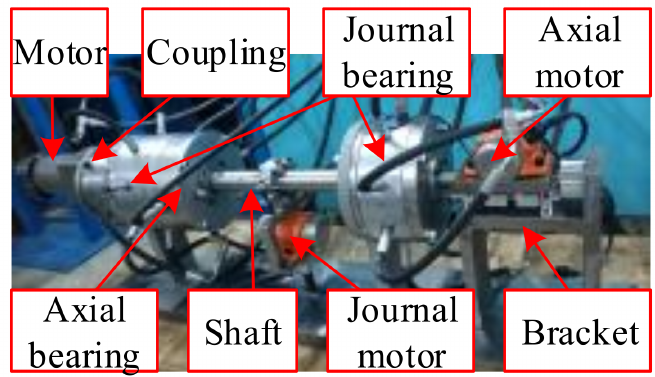
Figure 1. Semi-isometric view of MLDSB.